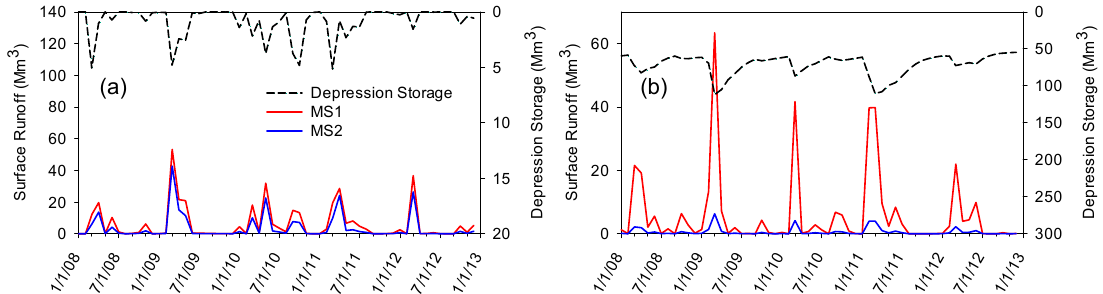
Figure 4. Simulated monthly surface runoff and depression storage of ( a ) subbasin 17 and ( b ) subbasin 127 in a selected time period (2008–2013) for modeling scenarios MS1 and MS2.